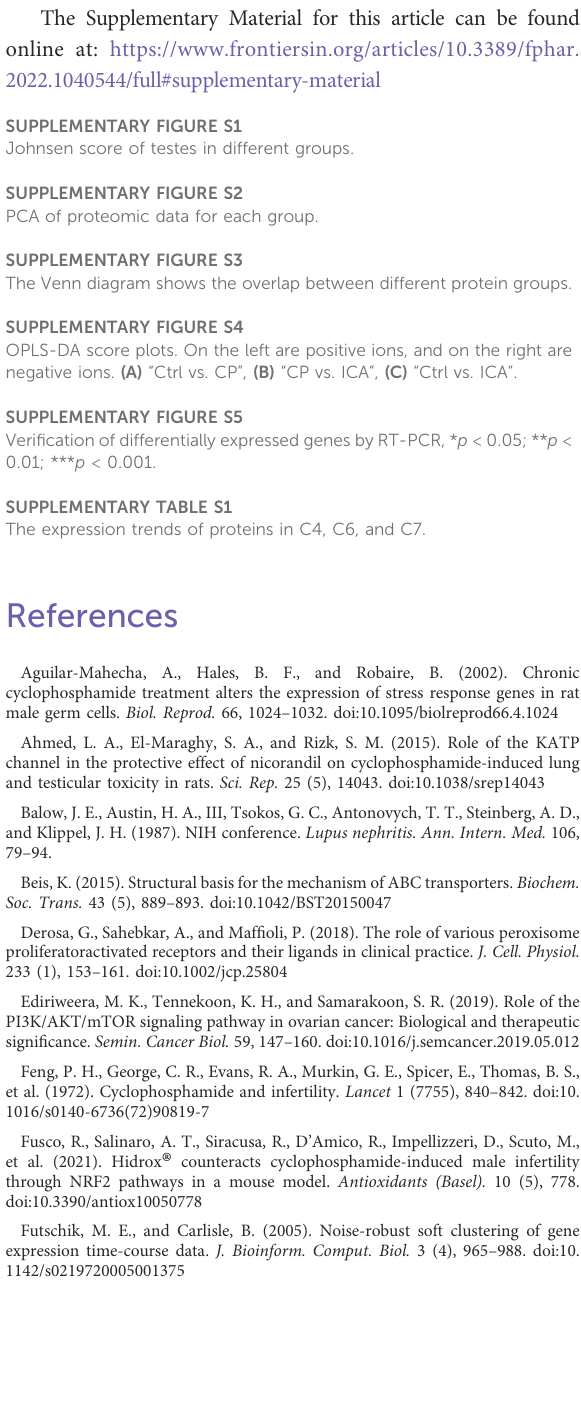
SUPPLEMENTARY TABLE S2 The enriched GO terms of dysregulated proteins. SUPPLEMENTARY TABLE S3 The enriched KEGG pathways of dysregulated proteins. SUPPLEMENTARY TABLE S4 The dysregulated metabolites in Ctrl vs. CP. SUPPLEMENTARY TABLE S5 The dysregulated metabolites in CP vs. ICA. SUPPLEMENTARY TABLE S6 The dysregulated metabolites in Ctrl vs. ICA.